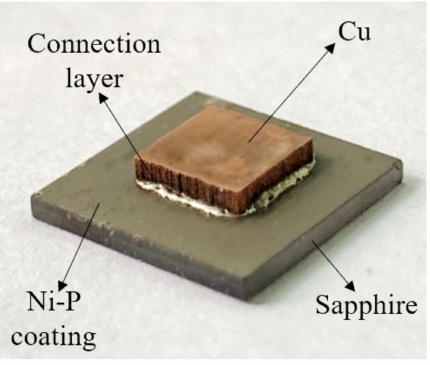
Figure 1. Macroscopic appearance of